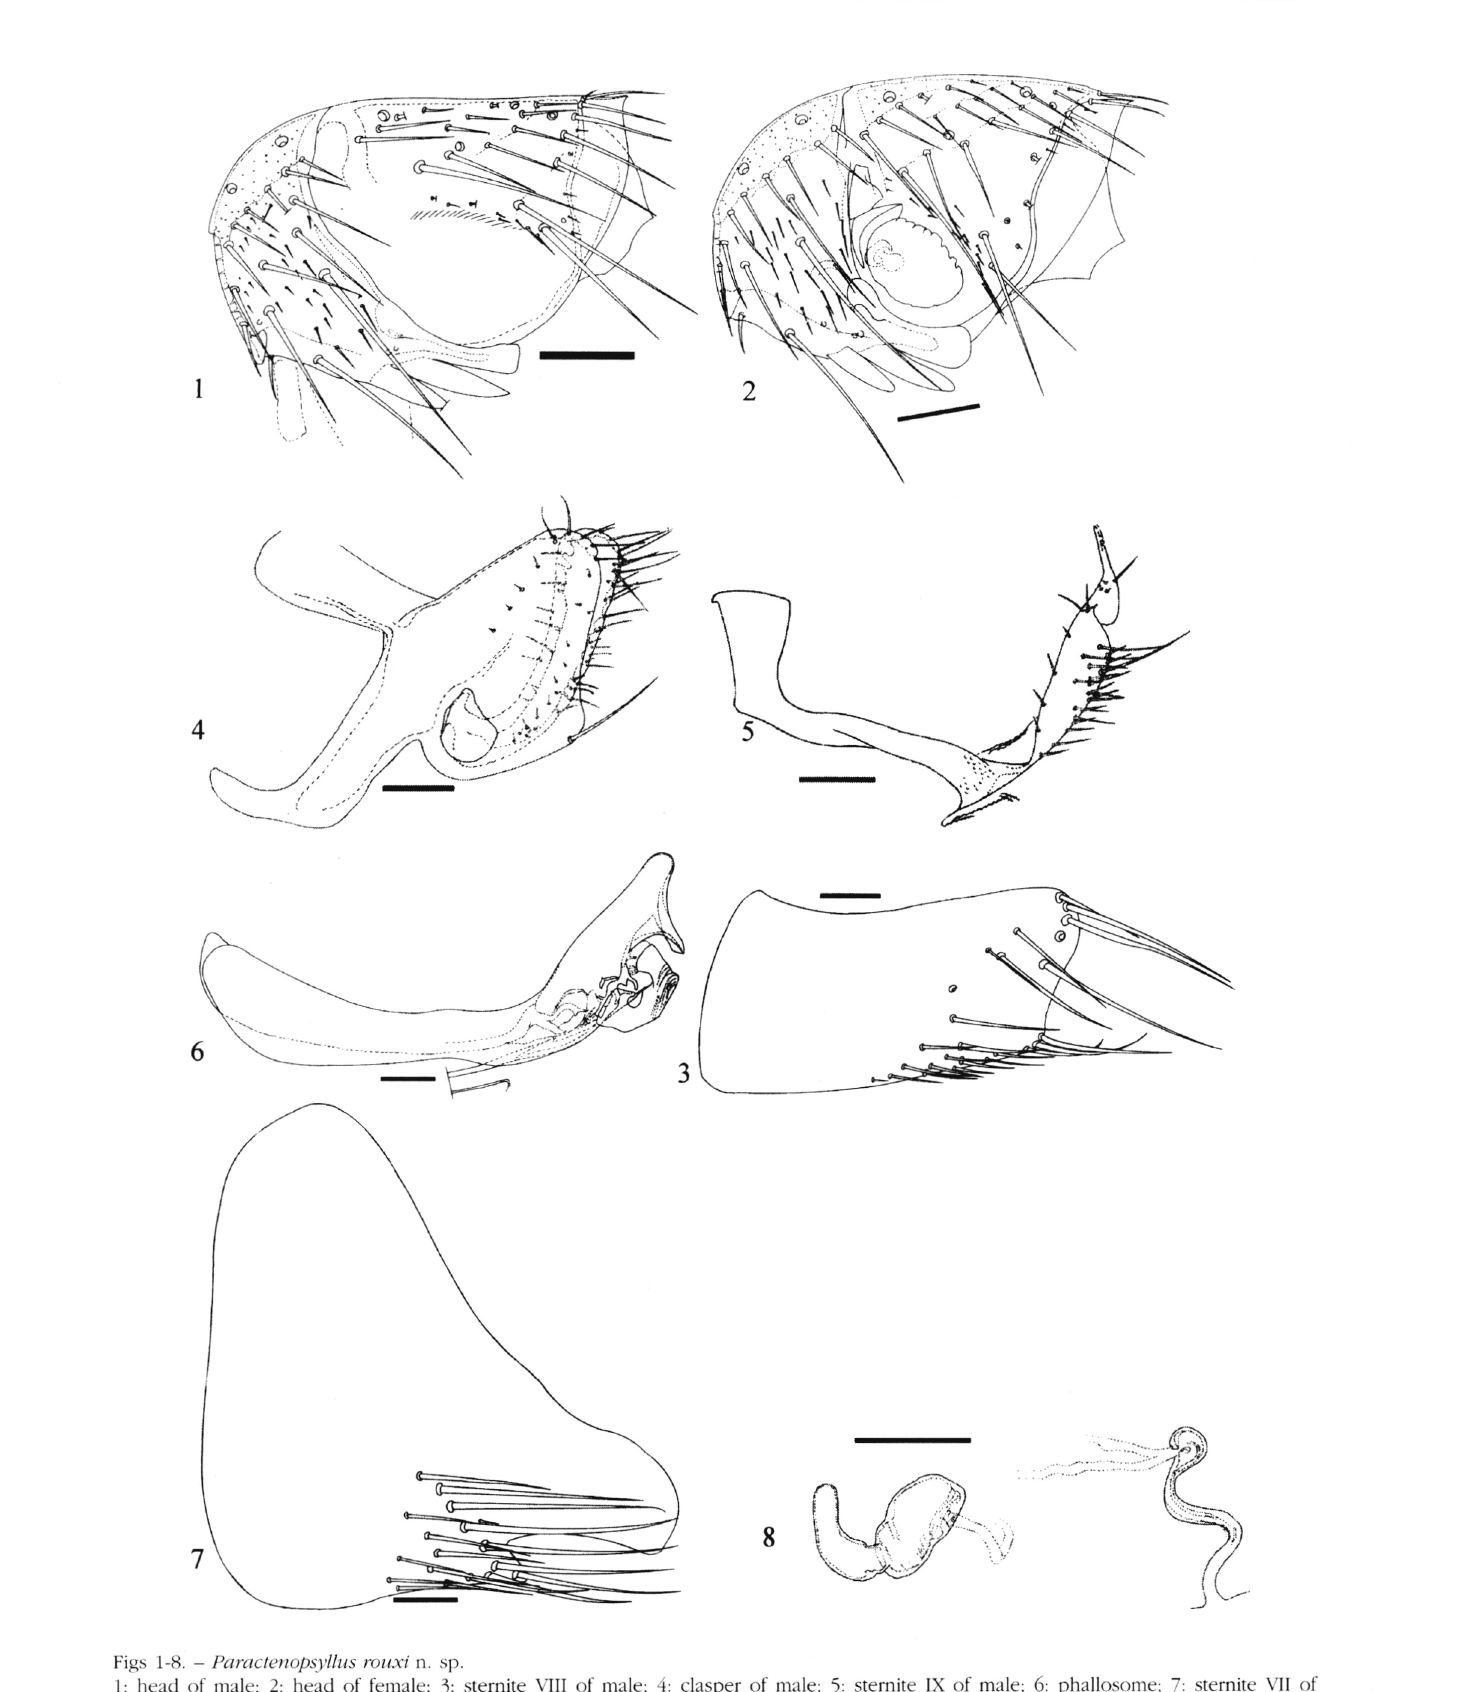
Figs 1-8. - Paractenopsyllus rouxi n. sp. 1: head of male; 2: head of female; 3: sternite VIII of male; 4: clasper of male; 5: sternite IX of male; 6: phallosome; 7: stemite VII of female; 8: spermatheca and ductus bursae. All scale bars = 0,1 mm. Parasite, 2004, 11,